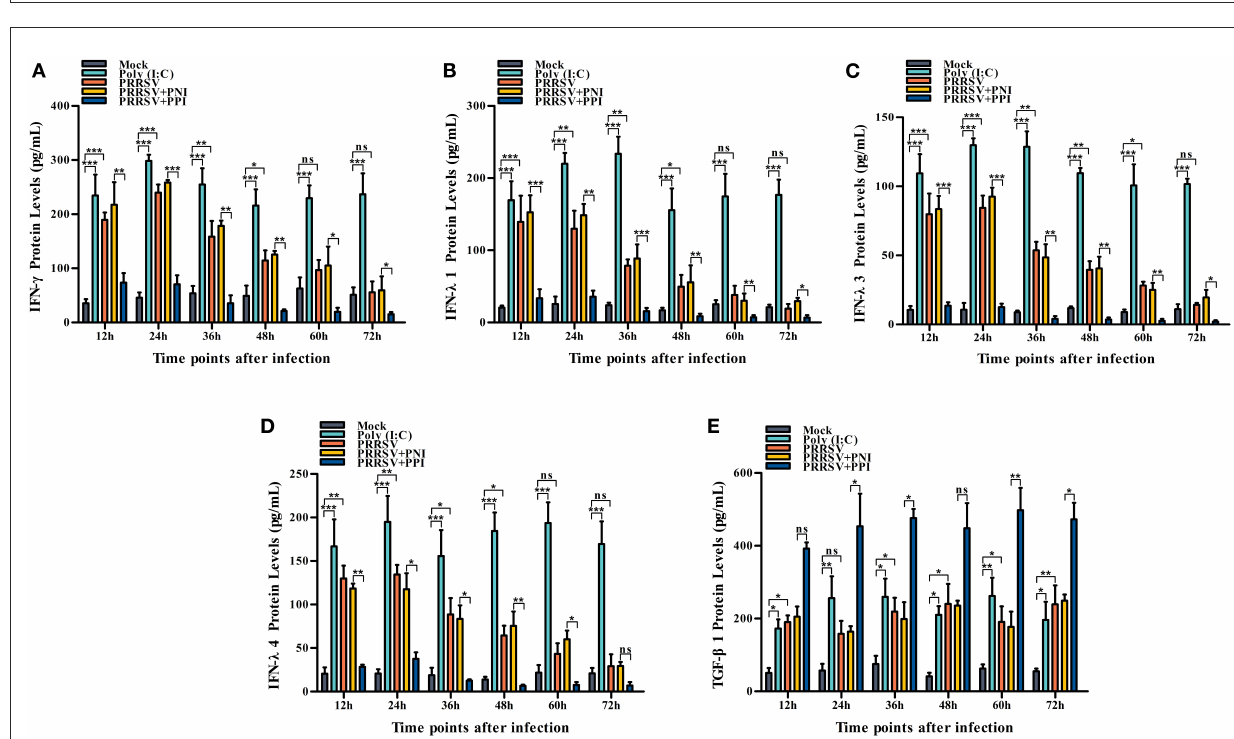
FIGURE3 The effect of PRRSV or PRRSV-ADE on proteins of the innate immune cytokines in PAMs. The proteins of the innate immune cytokines in the culture supernatants of the PAM cells treated with the indicated methods were quantified using commercial ELISA Kits. (A) IFN- γ protein, (B) IFN- λ 1 protein, (C) IFN- λ 3 protein, (D) IFN- λ 4 protein, and (E) TGF- β 1 protein. The bars indicate the protein concentrations of the innate immune cytokines. The error bars indicate the SEM from three independent experiments. *** p < 0.001, ** p < 0.01, * p < 0.05, and ns, no significance.